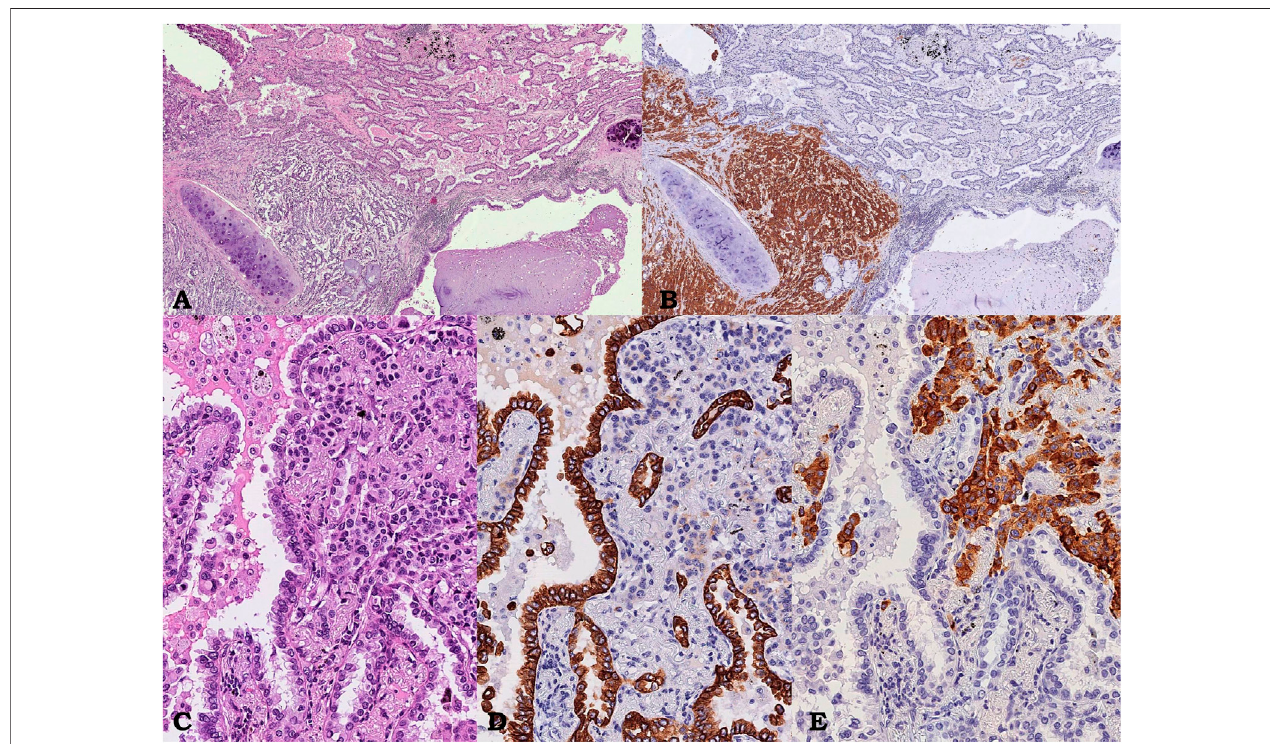
FIGURE 3 | Case 2, pulmonary neoplasm. Intraparenchymal neoplasm showing a glandular component corresponding to an acinar pulmonary adenocarcinoma on the right intermingled with an organoid proliferation of polygonal shaped uniform tumor cells on the left, near bronchus wall, corresponding to atypical carcinoid; hematoxylin/eosin, 3.5x (A) . Immunostaining showing diffuse and strong immunoreactivity for Synapto fi sin only in the carcinoid component ( on the left, 3.5x; B) , At higherpower fi eld,compositeneoplasm ( hematoxylin/eosin, C ,15x ) showingdiffuseandstrongimmunoreactivityforCK7onlyintheadenocarcinomatous (D 15x ) and chromogranin only in the neuroendocrine component (E , 15x ) ,